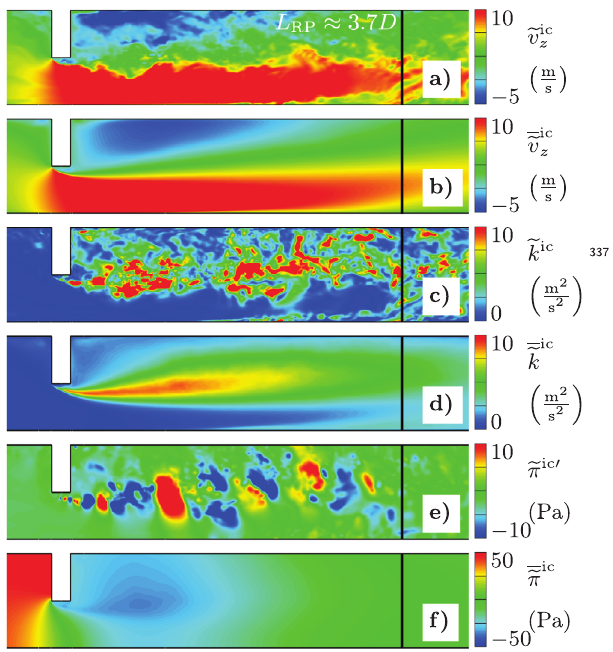
Figure 4. Contours of the (a) instantaneous axial velocity e v ic z and its mean value (b) e v ic z , the (c) instantaneous turbulent kinetic energy e k ¼ 1 ð e v ic 0 (cid:3) e v ic 0 Þ , and its mean value (d) e k ic , (e) the 2 instantaneous pressure fl uctuations e p ic 0 and its mean value and (f) e p ic for case C 1.